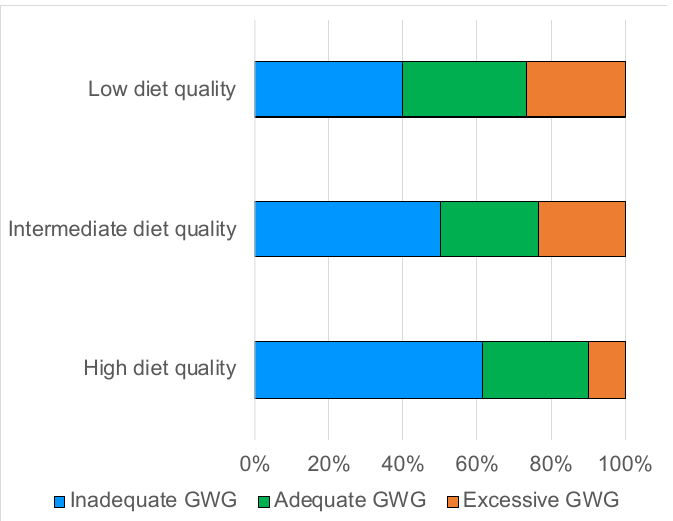
Figure 4. Relationship between diet quality assessed by NRF9.3 and GWG adequacy. Proportions (%) of inadequate, adequate, and excessive GWG across NRF9.3 are shown. Low, intermediate, and high diet quality correspond to low, intermediate, and high NRF9.3 score group, respectively. In contrast, the high JFGST scores increased the percentage of excessive GWG (Figure S2). Figure S3 scatter plots show the relationship between NRF9.3 and JFGST in the underweight (a) or normal weight (b) groups, color-coded with GWG adequacy presentation (blue, inadequate GWG; green, adequate GWG; orange, excessive GWG).